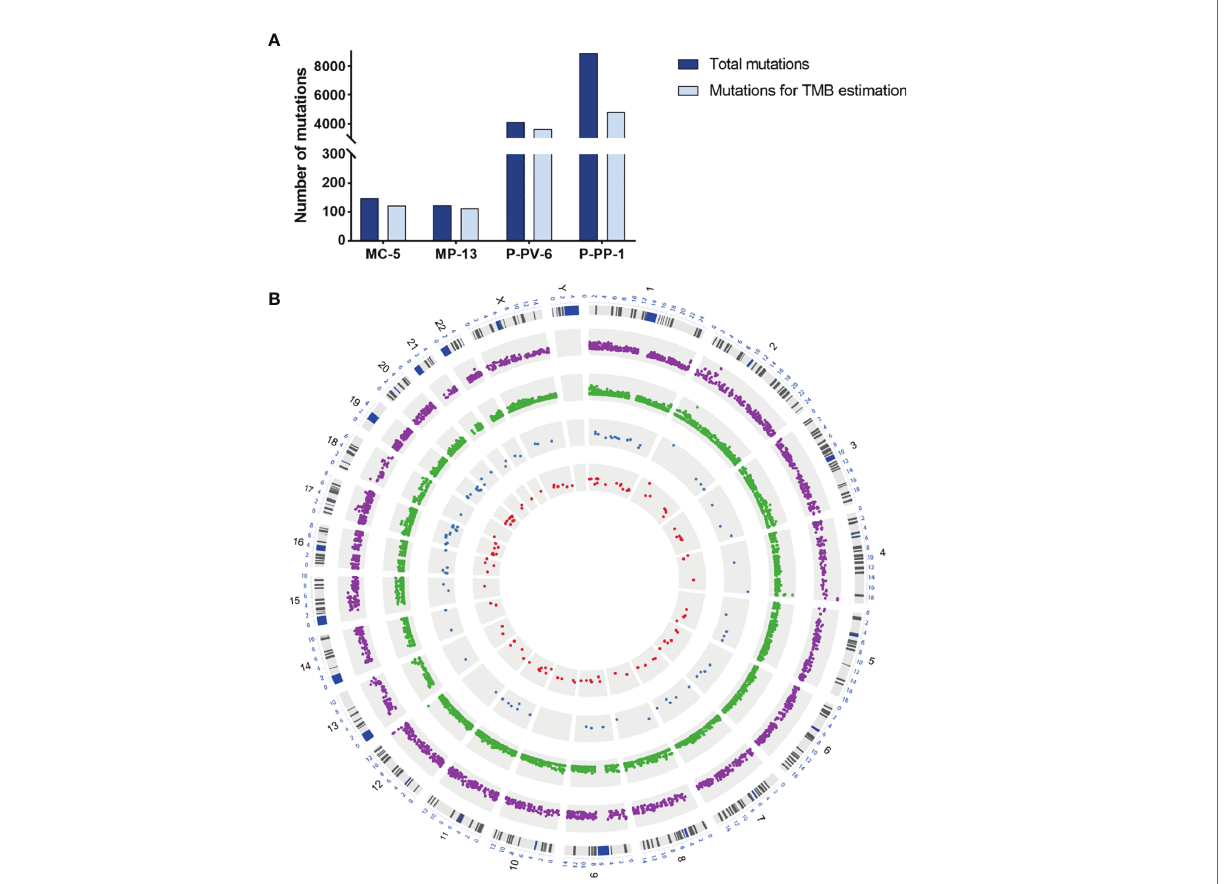
FIGURE 2 | The mutation landscape and TMB levels of MC-5, MP-13, P-PP-1, and P-PV-6. (A) Distribution of total nascent mutations and nonsynonymous mutations in four engineered cell lines. (B) Circos Plot of detected nascent mutations in four engineered cell lines. Outer purple Track: P-PV-6. Middle green track: P-PP-1. Middle blue track: MP-13. Inner red track: